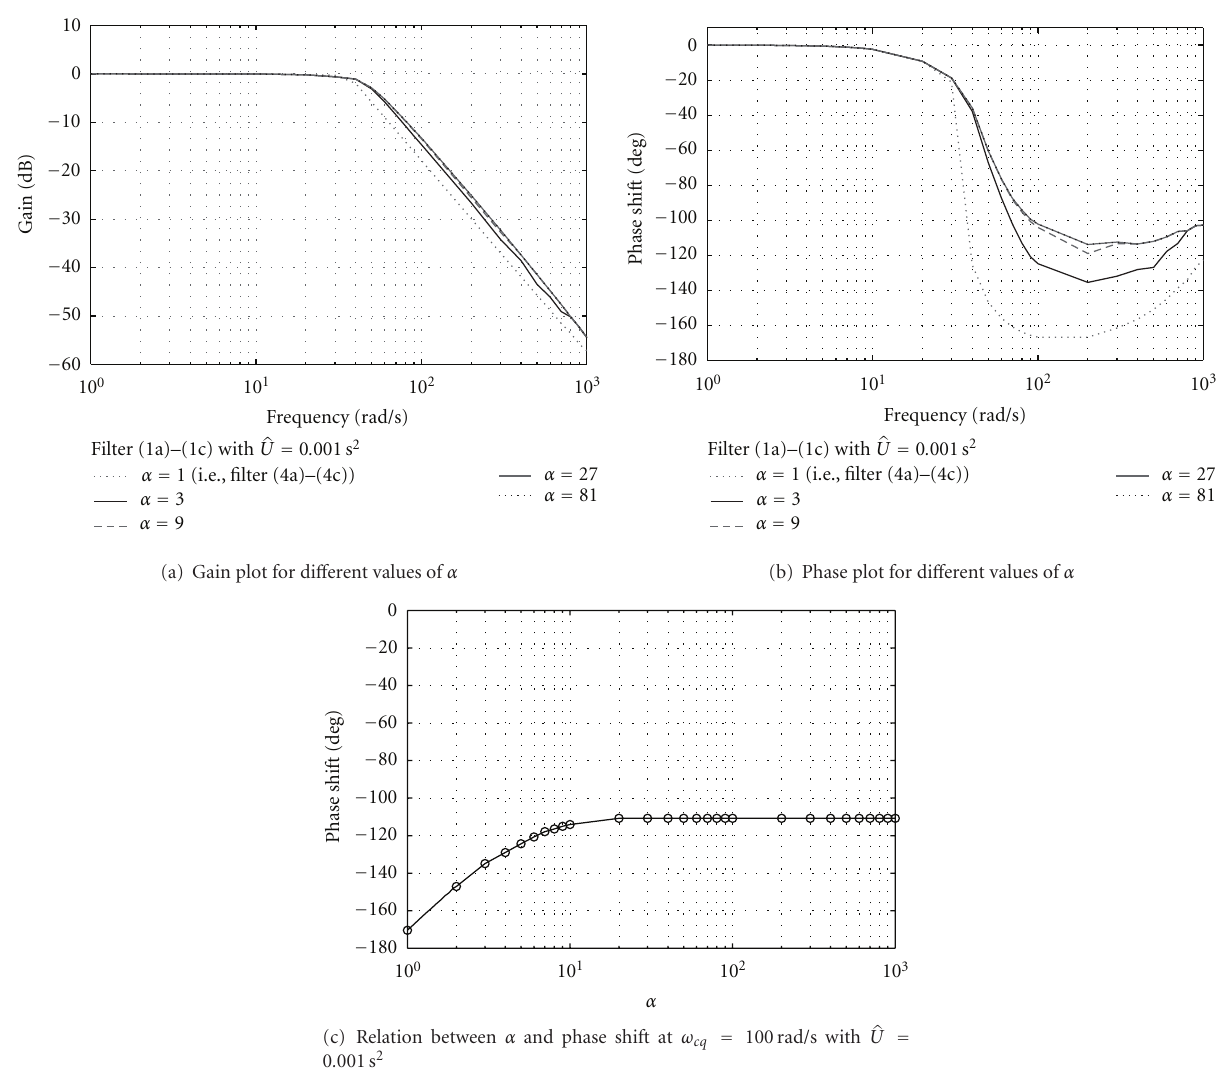
Figure 5: Influence of α on the gain and the phase shift. In each figure, the result of filter (1a)–(1c) with α = 1 refers to that of filter (4a)–(4c). 3.1. Bode Plots for Di ff erent Values of (cid:8) U . Figure 3 shows the Bode plots of filter (1a)–(1c) for di ff erent values of (cid:8) U . In filter (1a)–(1c), the frequency response depends on the input amplitude (cid:8) U because of the nonlinearity. Specifically, both the gain and the phase plots shift to the left by maintaining the same shape as (cid:8) U increases. For comparison, Bode